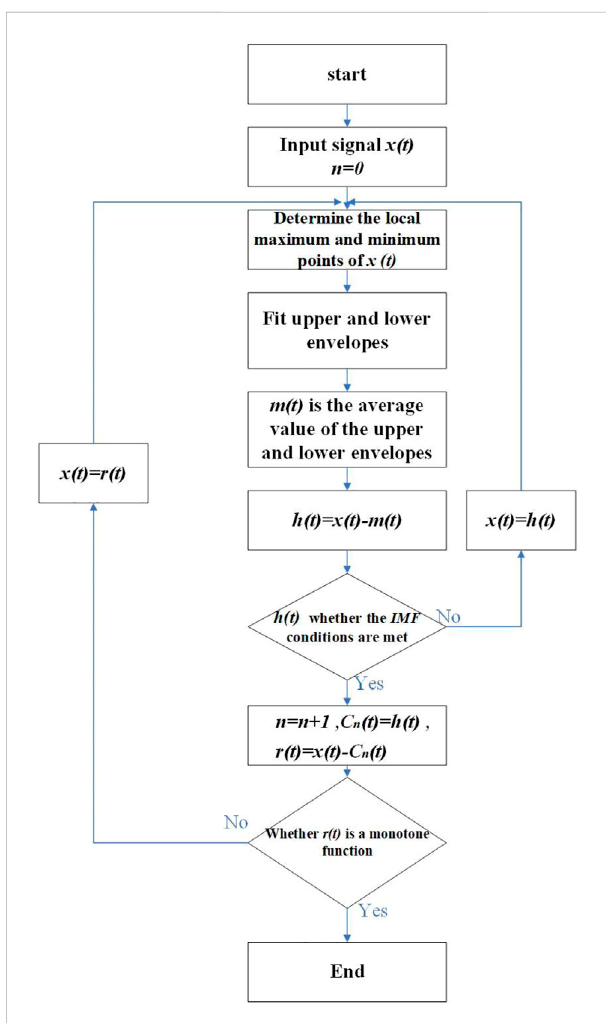
FIGURE 1 The fl ow chart of empirical mode decomposition